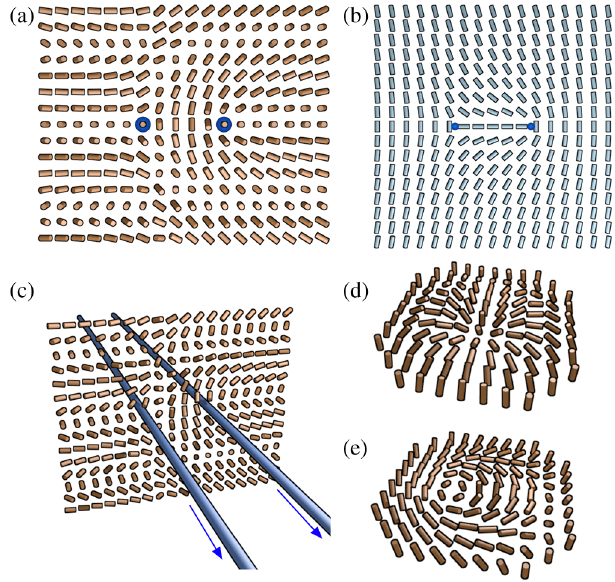
FIG. 1. Umbilic lines. (a) λ þ λ − dislocation in a cholesteric. It contains two generic umbilics. This combination of two generic umbilics can be identified as half a Skyrmion, or a meron. (b) Eigenvector field of Π for the dislocation. The two umbilics have opposite windings of the eigenvectors, but are counted with the same sign as n rotates by π when passing from one to the other. (c) Umbilic lines can be oriented in three dimensions. (d), (e) Typical centers of vortices, based on curvature and torsion distortions, respectively, that correspond to winding number two nongeneric